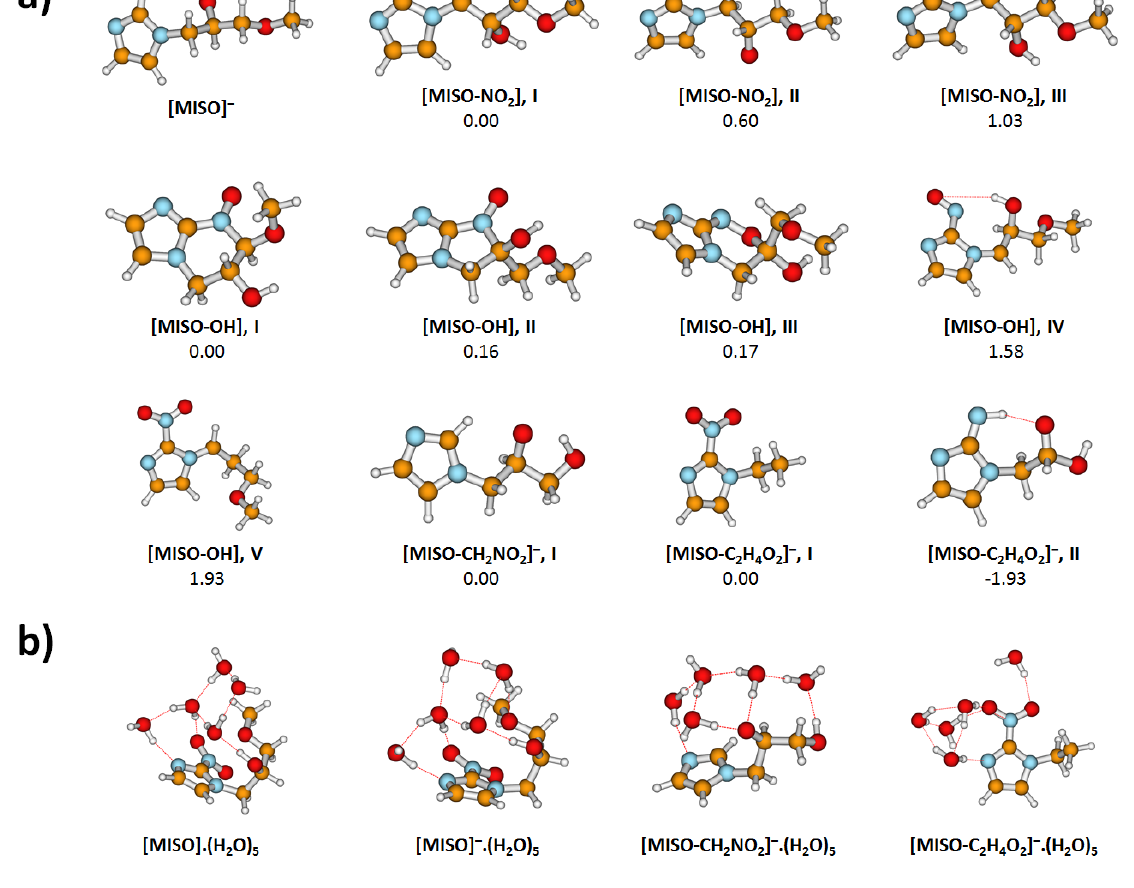
Figure 3. Optimized structures of MISO clusters and dissociation fragments, calculated at the B3LYP+D2/aug-cc-pVDZ level. ( a ) Various isomers of non-hydrated dissociation products, along with relative energy (in eV). ( b ) Selected hydration structures for five water